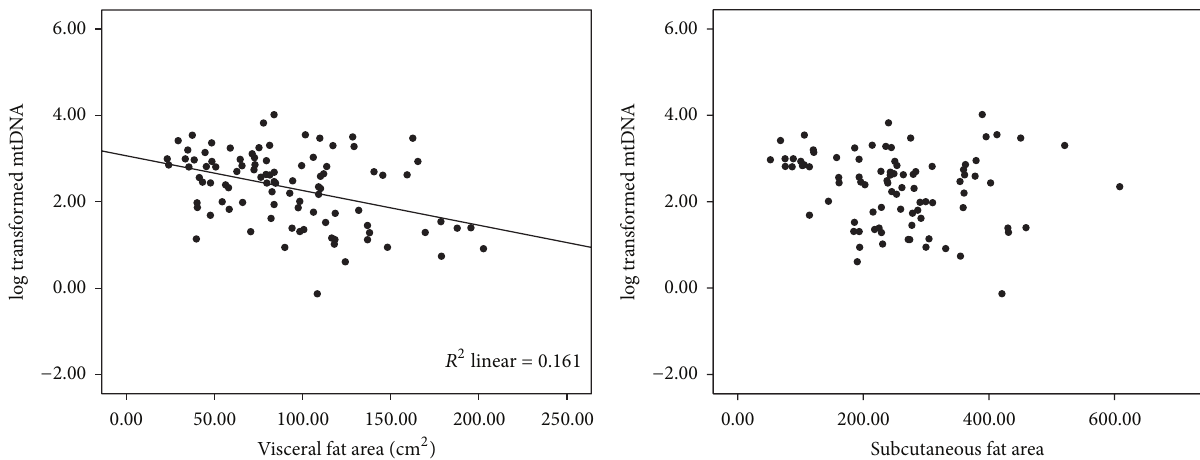
Figure 1: The relationship between abdominal visceral fat area, abdominal subcutaneous fat area, and mtDNA copy numbers. Coefficients ( 𝑟 ) and 𝑃 values were calculated using the Pearson correlation model.